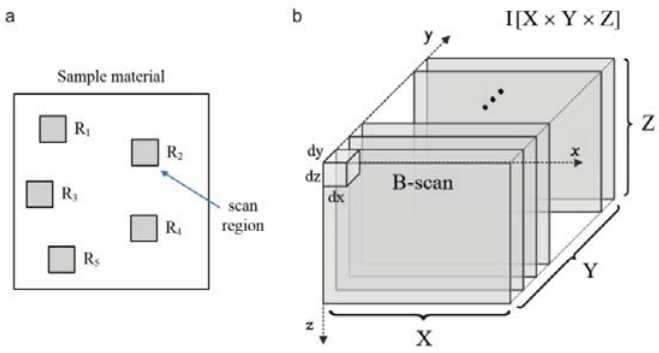
Figure 7. Block diagram of the Spark OCT 1300 nm system.